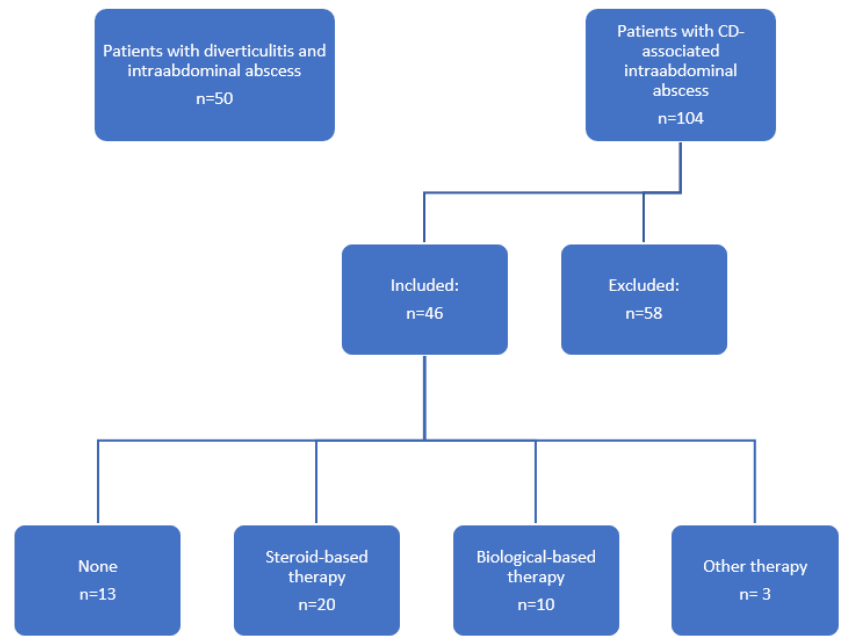
Figure 1. Study design.